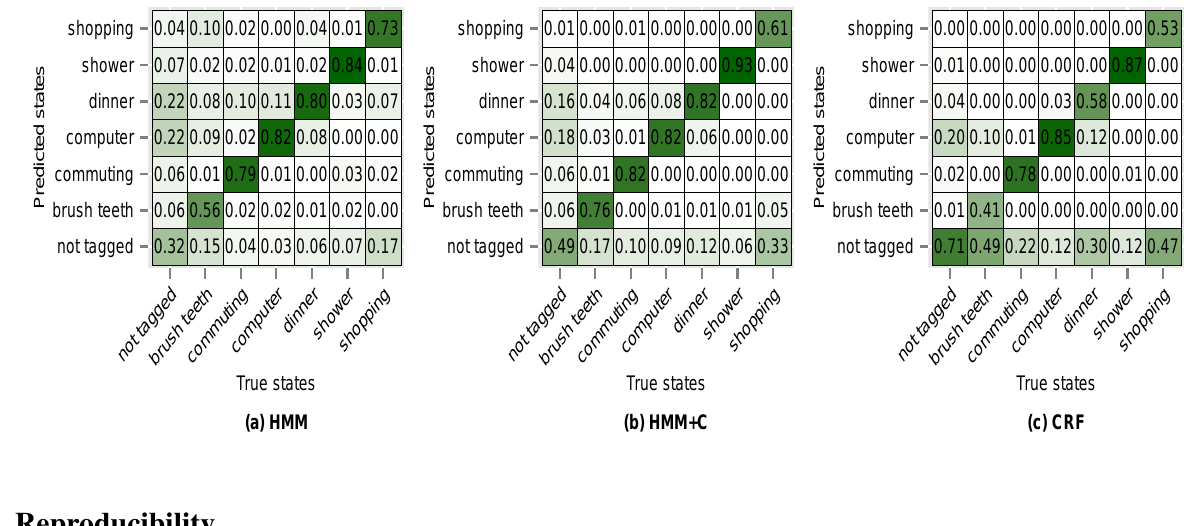
Figure 13. Confusion matrices for experiment 5 (subject 1): GDI33